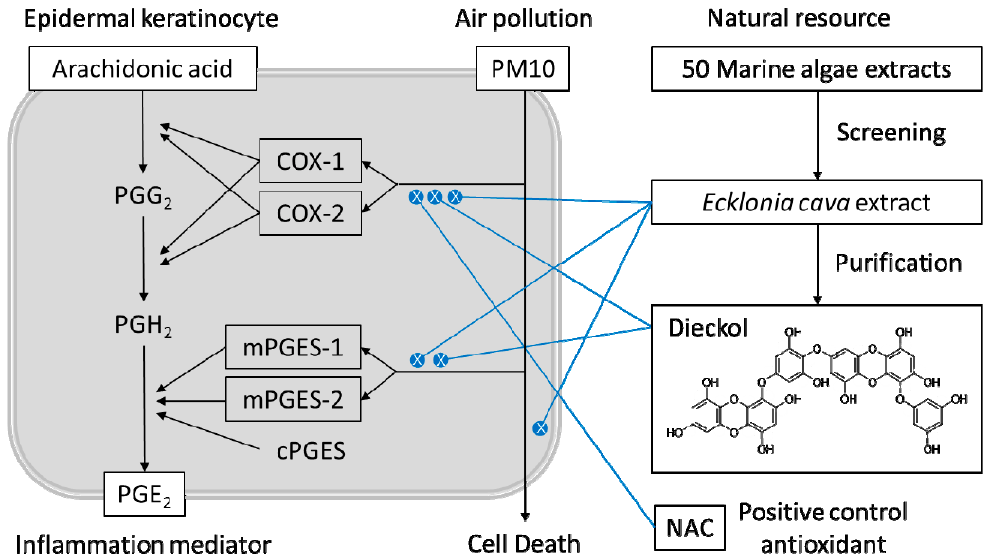
Figure 10. Summary. Ecklonia cava extract and its component, dieckol, can alleviate PM10-induced PGE 2 production in keratinocytes through the inhibition of COX-1, COX-2, mPGES-1, and / or mPGES-2 gene expression.